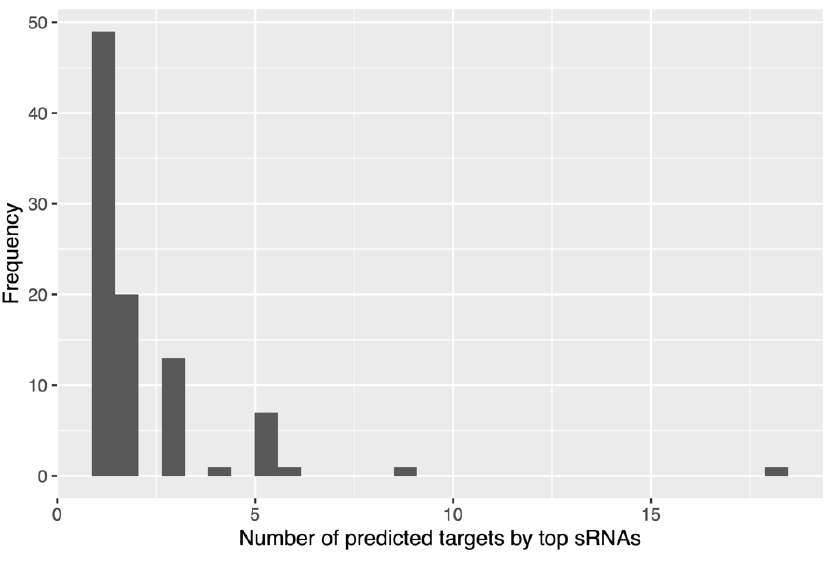
Figure 5. Frequency of small RNAs obtained with respect to mRNAs of genes associated with cho- lesterol.